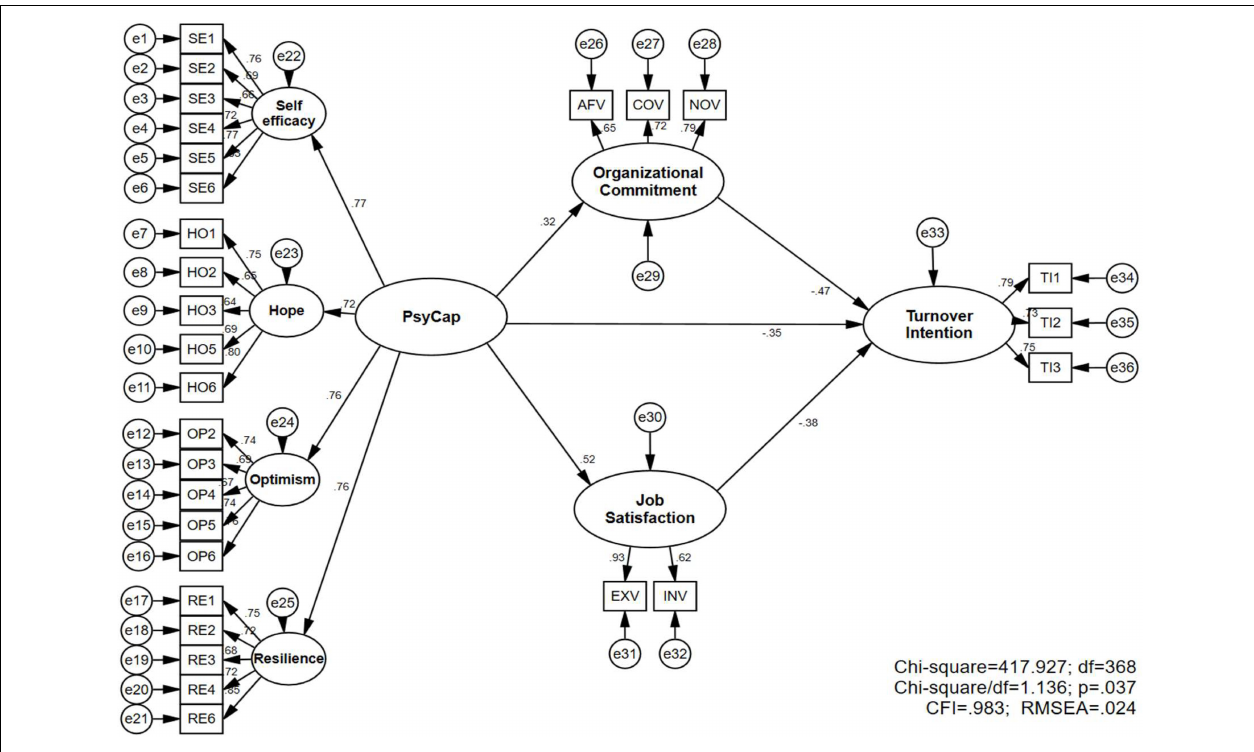
FIGURE 2 | Final structural